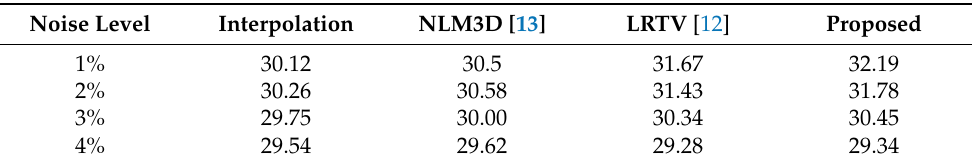
Table 4. PSNR values for reconstructed images of randomly selected subject degraded with down- sampling factor 2 and different levels of noise.